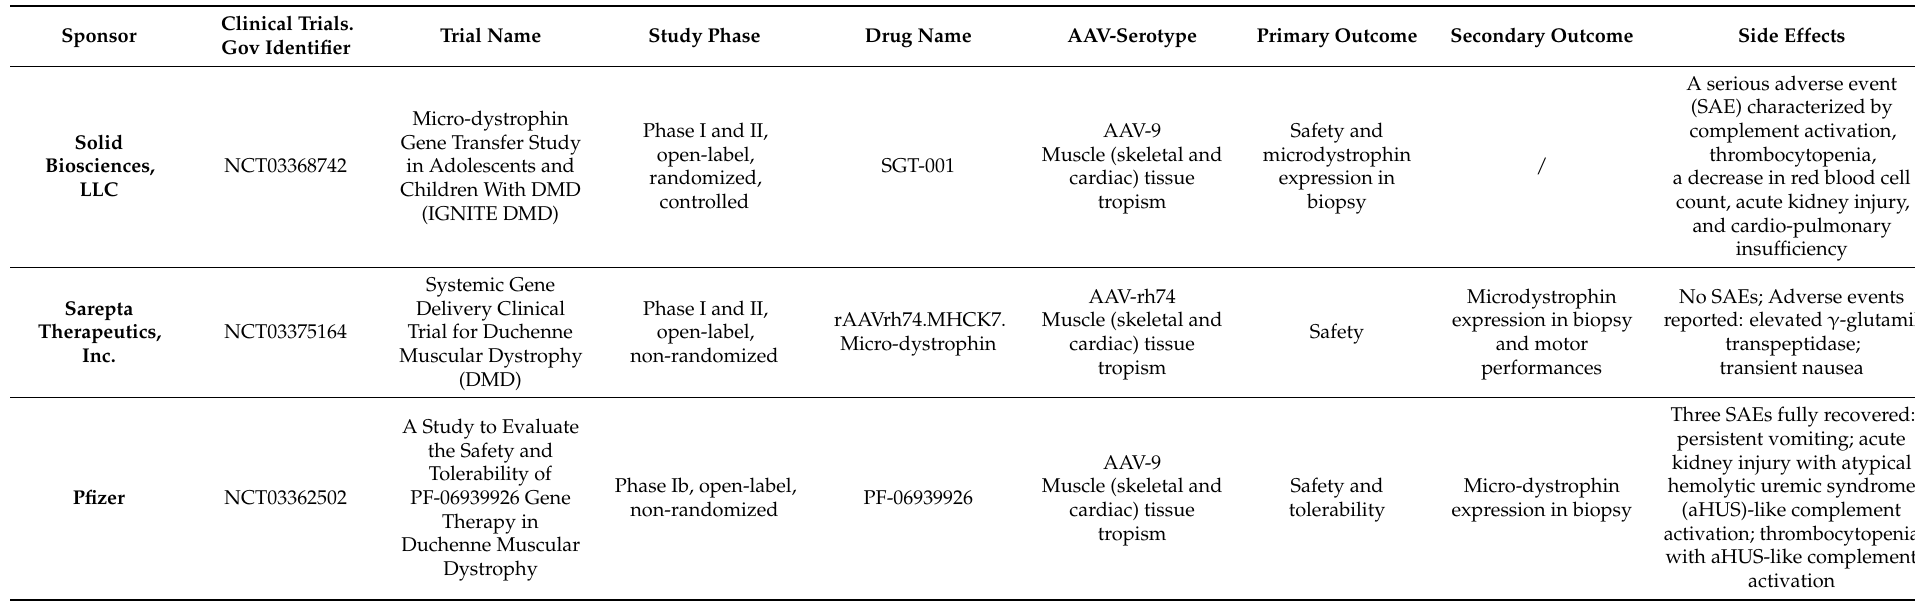
Table 3. Overview of AAV-mediated gene therapies in DMD clinical trials (http://clinicaltrials.gov (accessed on 15 January